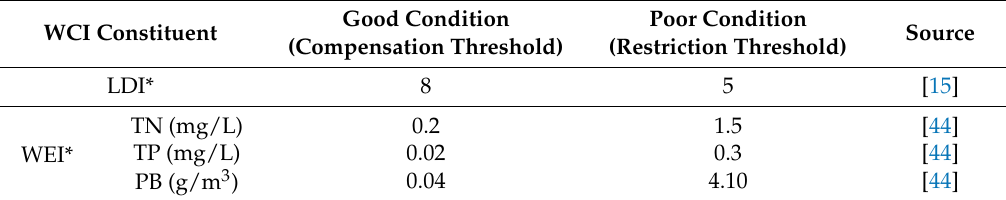
Figure 2. The nine situations (connecting line) about LDI* paired with WEI* (the red line represents L1W1, L1W2, L1W3, W1L2, and W1L3; the yellow line represents L2W2, L2W3, and L3W2, and the green line represents L3W3). L1 (red rectangle above), L2 (yellow rectangle above), and L3 (green rectangle above) represent the value of LDI* ranged from 0 to LDI* res , LDI* res to LDI* com , and LDI* com to 10, respectively, while W1 (red rectangle below), W2 (yellow rectangle below), and W3 (green rectangle below) are the same. The WCI calculated formulas from different pairs of LDI* and WEI* are listed in Table 1. Table 2. Summary of threshold limits for constituents.